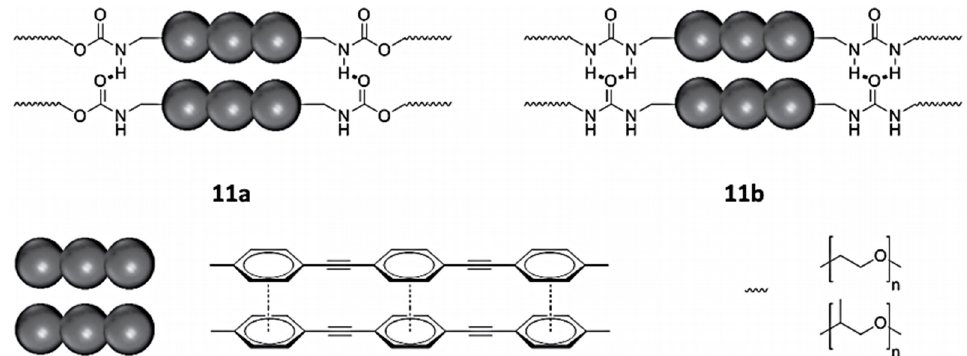
Figure 45. Schematic representation of supramolecular interactions of π -conjugated urethane-based polymer ( 11a ) and π -conjugated urea based polymer ( 11b ). From reference [34].